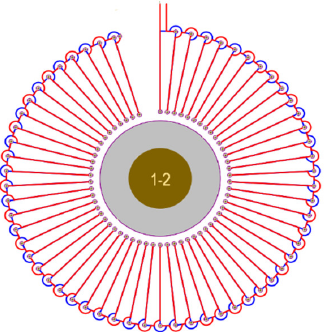
Figure 5. Differential winding coil structure.